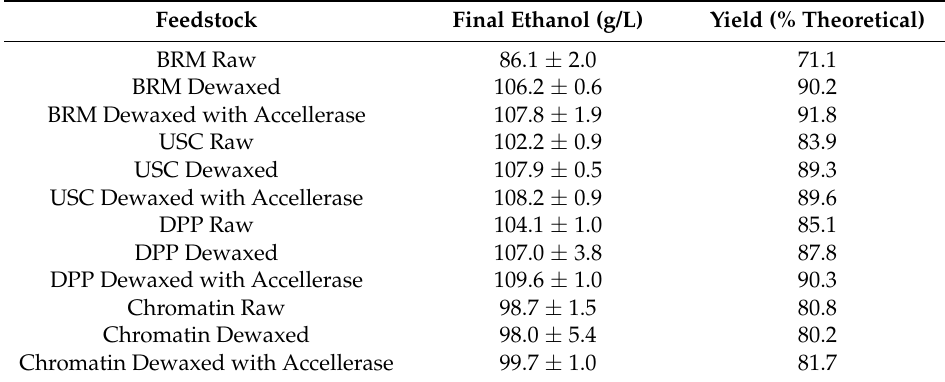
Table 4. Final ethanol concentrations in the simultaneous saccharification and fermentation (SSF) of raw and dewaxed sorghum grains.